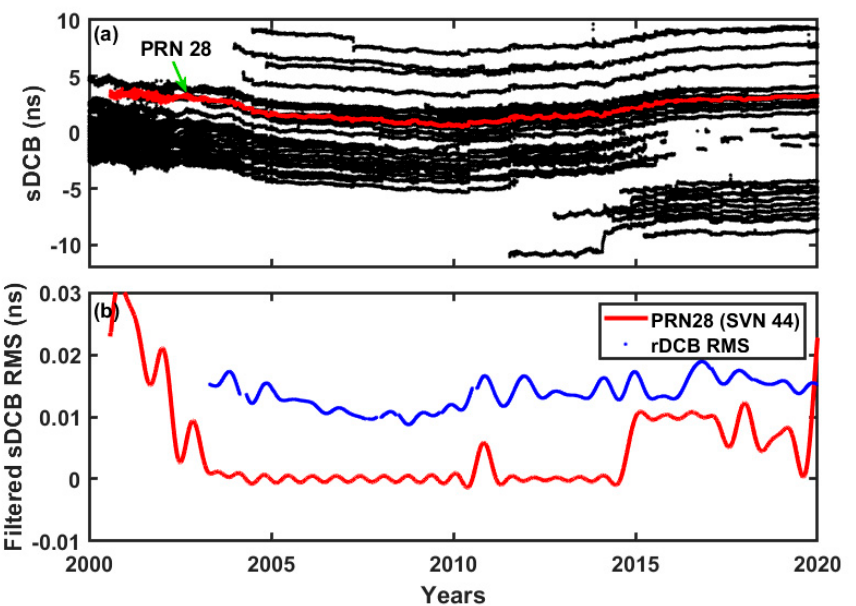
Figure 2. ( a ) Time series of all GPS satellite P1-P2 DCB (sDCB) from 2000 to 2020. The red dots indicate the changes in DCB values for GPS satellite PRN 28. ( b ) Time series of band-pass filtered (0~1.5 Hz) sDCB RMS for GPS PRN 28 (SVN 44), and band-pass filtered (0~1.5 Hz) rDCB RMS from 2000 to 2020. The red solid line and blue dots represent the filtered RMS changes for GPS satellite PRN 28 DCB and rDCB at BOGT station, respectively.